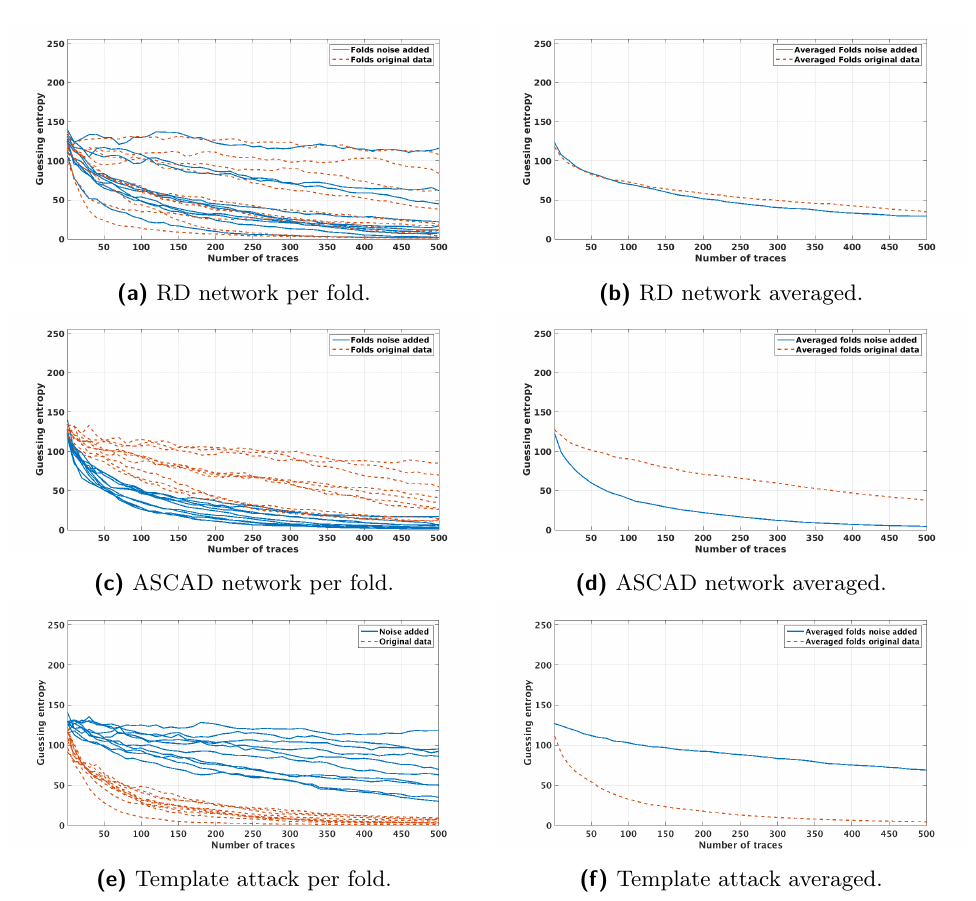
Figure 6: Guessing entropy results for the ASCAD